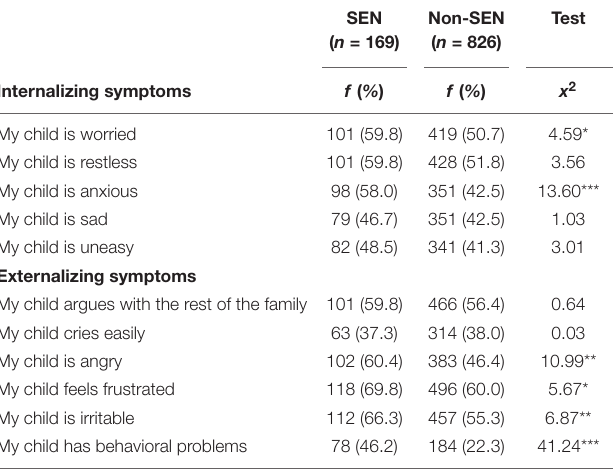
TABLE 2 | Between-group differences in caregivers’ perception of change in children’s internalizing and externalizing symptoms before and during the